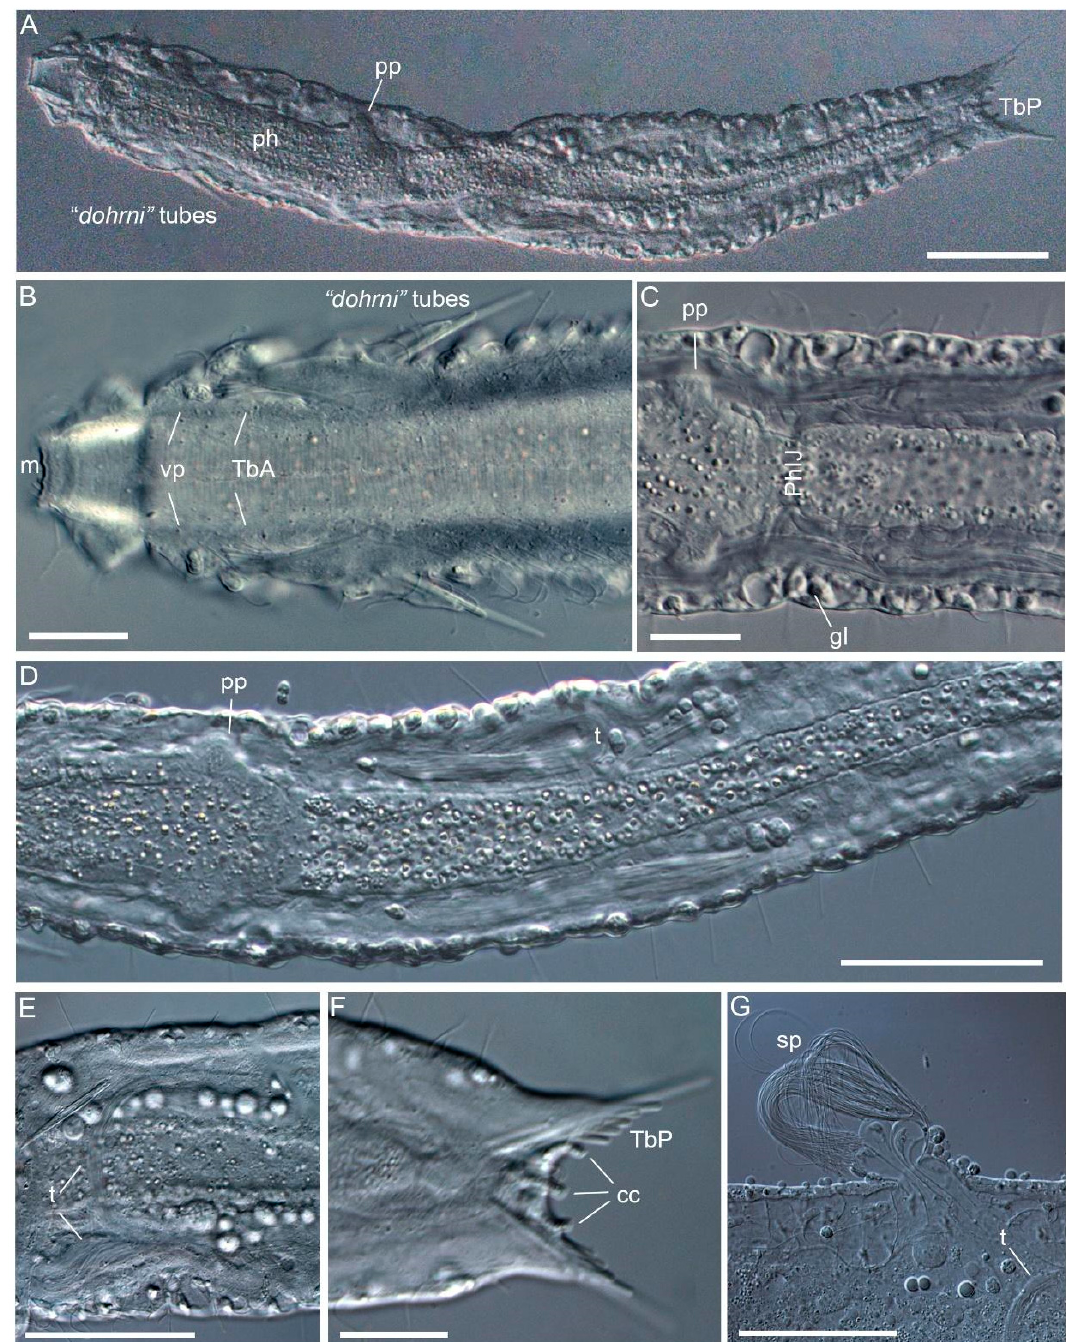
Figure 3. Paraturbanella tricaudata sp. nov. DIC photomicrographs. ( A ) Dorsal view of the Habitus. ( B ) Anterior region showing the mouth (m), peribuccal swellings, anterior adhesive tubes (TbA), “dohrni” tubes and ventral papillae (vp). ( C ) Pharyngeal pores (pp), pharyngo-intestinal junction (PhIJ), and epidermal glands (eg). ( D ) Paired testes (t)—they are lateral and extend posteriorly, with sperm ducts. ( E ) Sperm duct recurving to the front of the mid-intestine. ( F ) Caudal lobes, posterior adhesive tubes (TbP), and caudal cones (cc). ( G ) Sperm (sp) released from the side of the body due to excessive compression. Scale bar: A = 50; B , C , E , F = 20; D = 40; G = 10 µm.